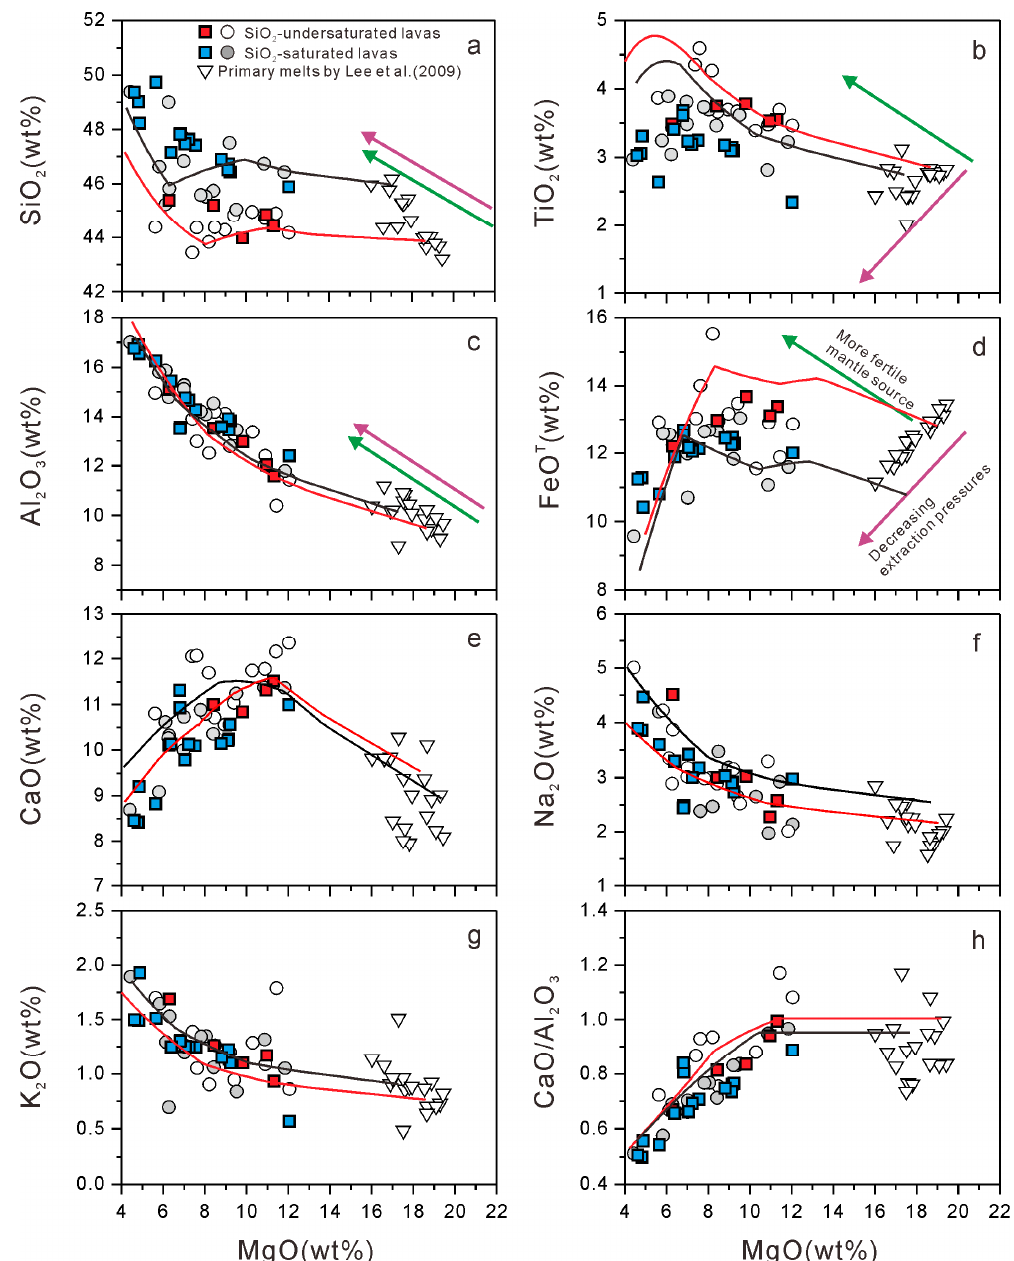
Figure 4. Major-element ( a ) SiO 2 , ( b ) TiO 2 , ( c ) Al 2 O 3 , ( d ) FeO T , ( e ) CaO, ( f ) Na 2 O, ( g ) K 2 O and ( h ) CaO / Al 2 O 3 variation diagram as a function of MgO content. Modelled liquid lines of descent for SiO 2 -saturated (black lines) and SiO 2 -undersaturated (red lines) lavas, as estimated by the Petrolog3 program [32], are included. Olivine–melt equilibrium models were from Gaetani and Watson [33]; clinopyroxene–melt equilibrium models from Ariskin et al. [34]; and magnetite–melt and ilmenite–melt equilibrium models from Ariskin and Barmina [35] and Nielsen [36], respectively. Major-element data from previous studies are included for comparison [9,10,18]. Compositional trends [37] of melts derived from less to more fertile mantle (green arrows) and from high to low pressures of melt extraction (purple arrows) are shown in ( a – d ).